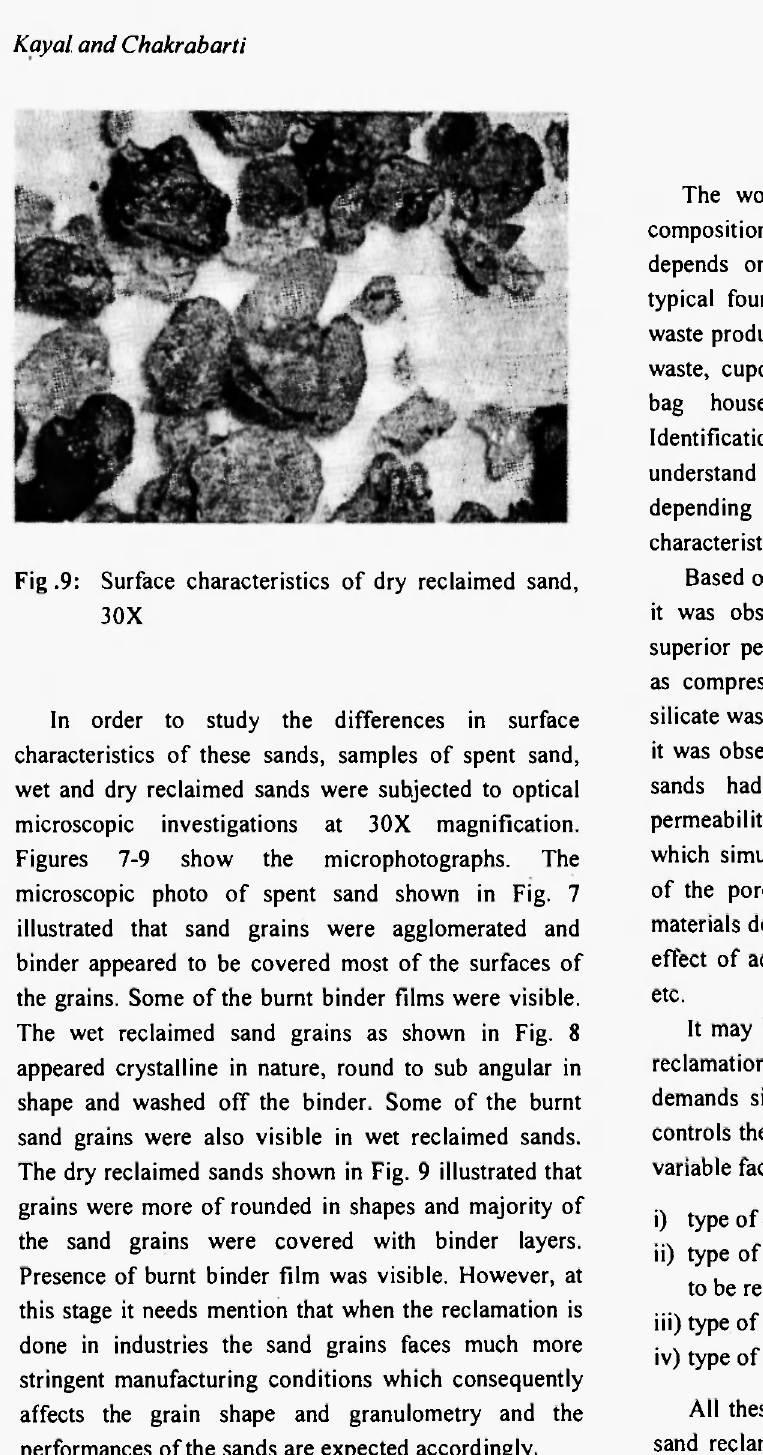
Fig .9: Surface characteristics of dry reclaimed sand,